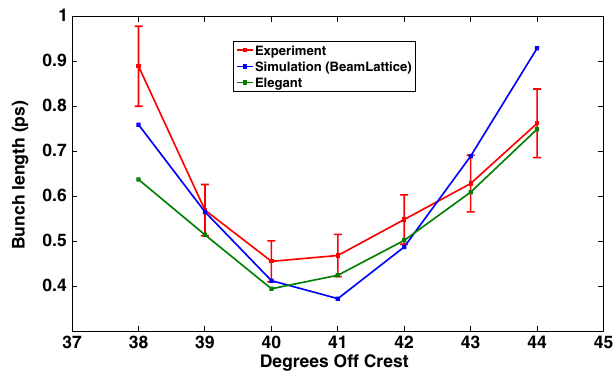
FIG. 6. Root-mean square bunch-length comparison for an ELEGANT simulation including CSR, a single-particle-matrix simulation without CSR, and the measurements. The charge was 250 pC.